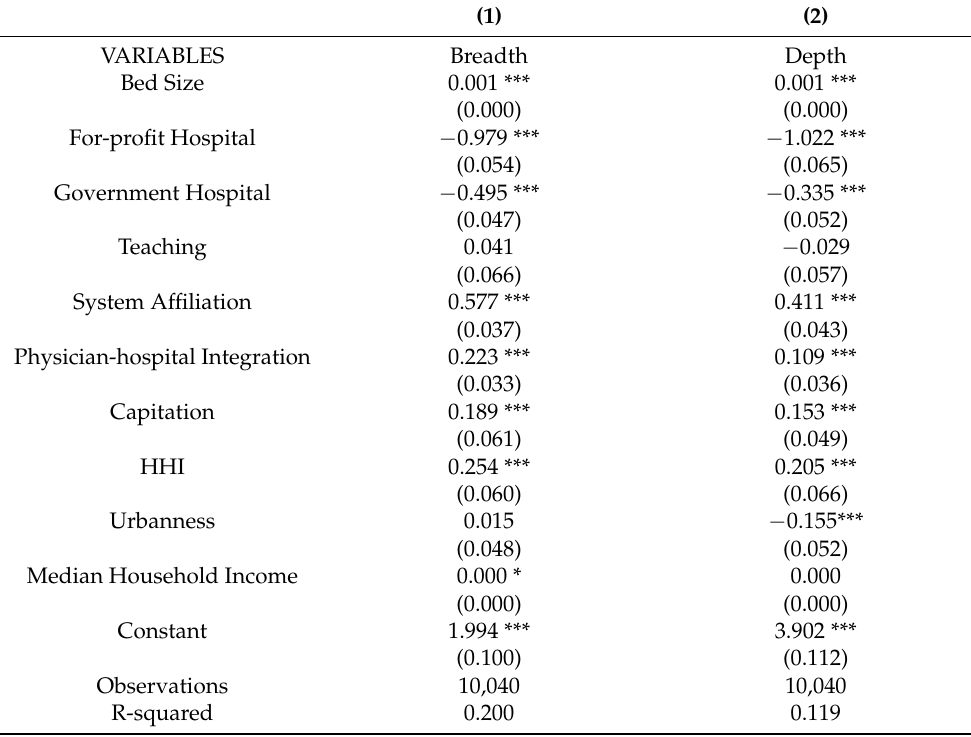
Table 2. Hospital- and Market-level Determinants of Information